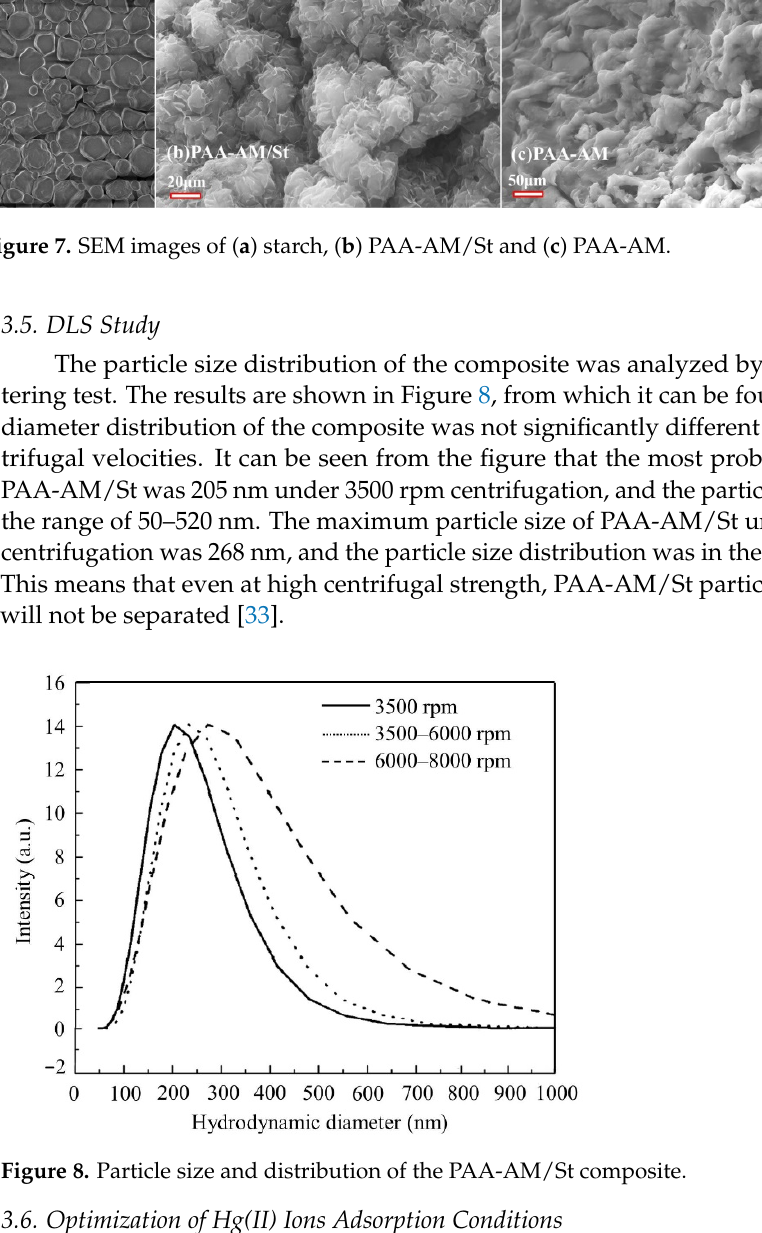
7 of 15 Figure 6. The TG and DTG curves of PAA-AM/St. 3.4. Morphology Analysis The surface morphology of the starch, PAA-AM and PAA-AM/St were observed us- ing scanning electron microscopy (SEM). It can be seen from Figure 7a that the electron micrographs of pure starch samples clearly exhibited irregularly shaped granular struc- ture. Figure 7b shows that integrating starch particles into PAA-AM copolymer can form composites with large specific surface area and uniform morphology. Evidently, incorpo- rating starch granules onto PAA-AM matrix generated a flower shaped structure with starch evenly packaged by PAA-AM. With the formation of a large number of gaps and ravines on the surface, the specific surface area of the composite increased sharply, which makes it easier to carry more active adsorption sites. Therefore, Hg(II) ions can be easily adsorbed. The morphology of PAA-AM/St (Figure 7b) can be divided into three parts. The bright bulges are presumed to be the furrows in the composite, the gray area are probably the gullies between the furrows, and the dark regions are speculated to be cavities created during graft copolymerization [32]. Combining all these three parts, PAA-AM/St was